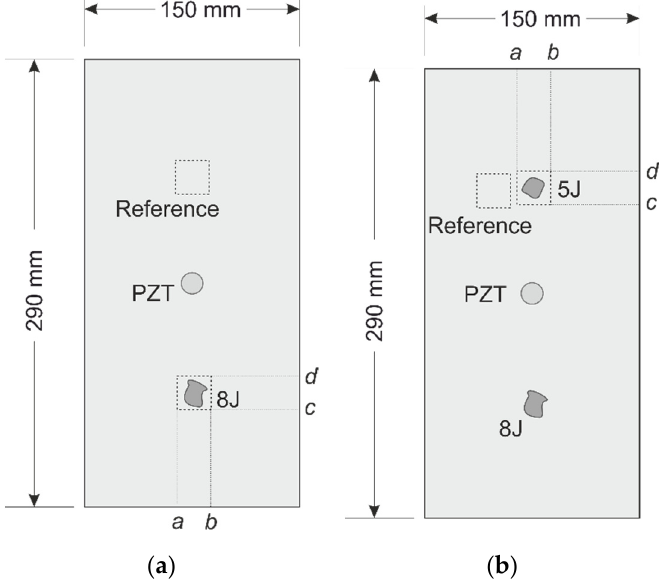
Figure 10. Specimen with barely visible impact damage (BVID): ( a ) 8 J scenario; ( b ) 5 J scenario.